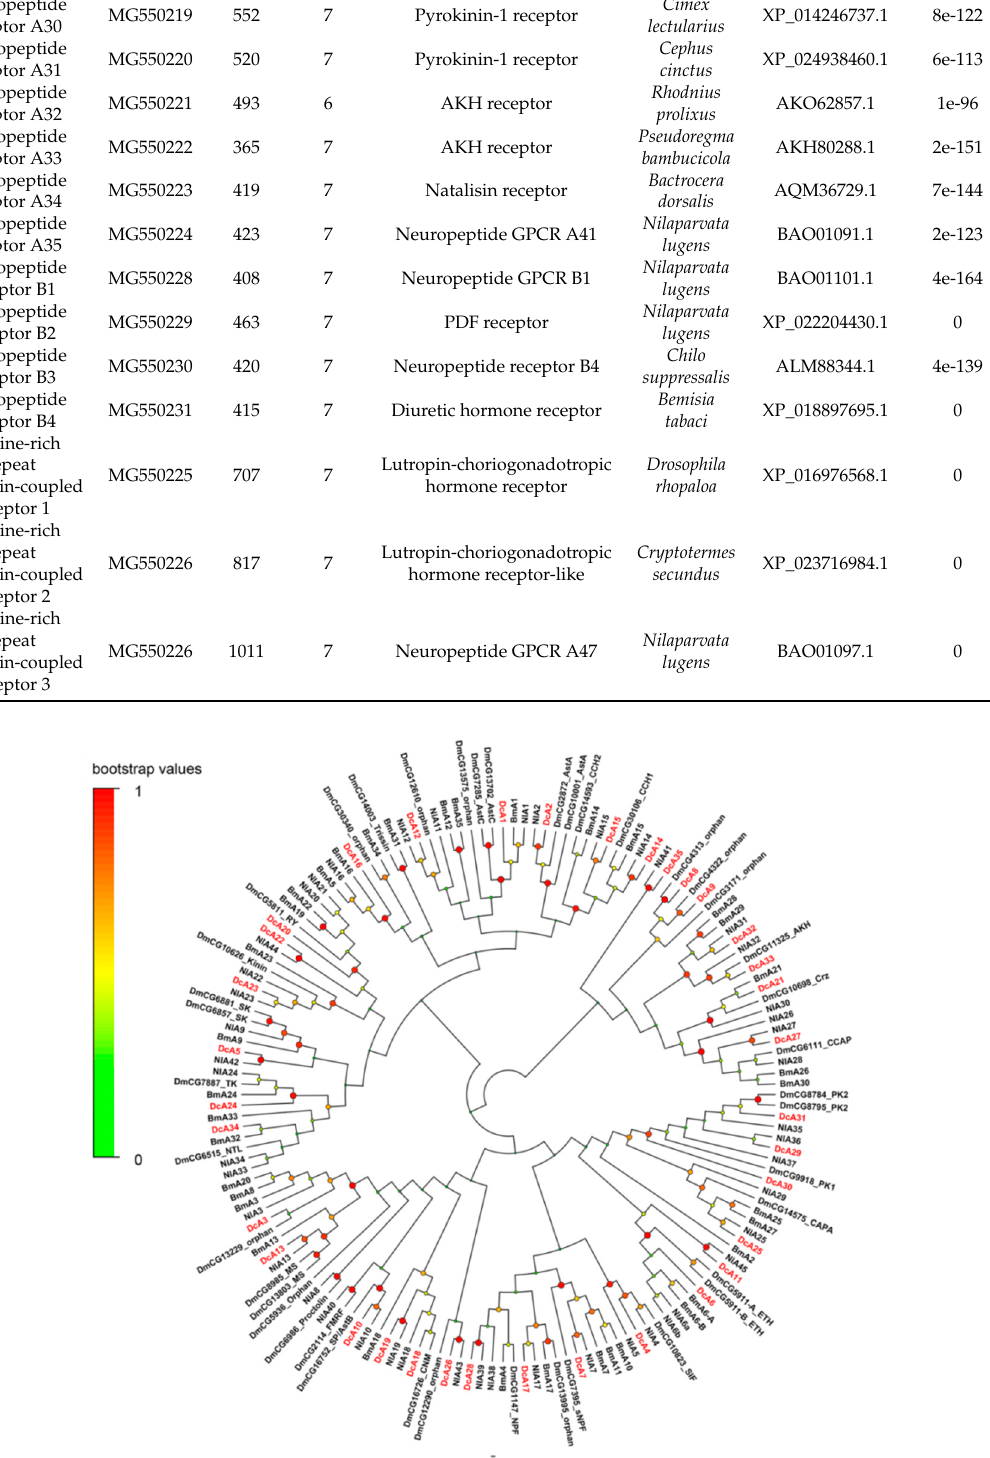
Figure 3. Phylogenetic tree of the B-family neuropeptide GPCRs. The neighbor-joining trees were constructed using MEGA 6 software with 1000-fold bootstrap repetitions. The B-family neuropeptide GPCRs of D. citri are shown in red text. Dc, D. citri ; Dm, D. melanogaster ; Nl, N. lugens ; Bm, B. mori ; Tc, T. castaneum .